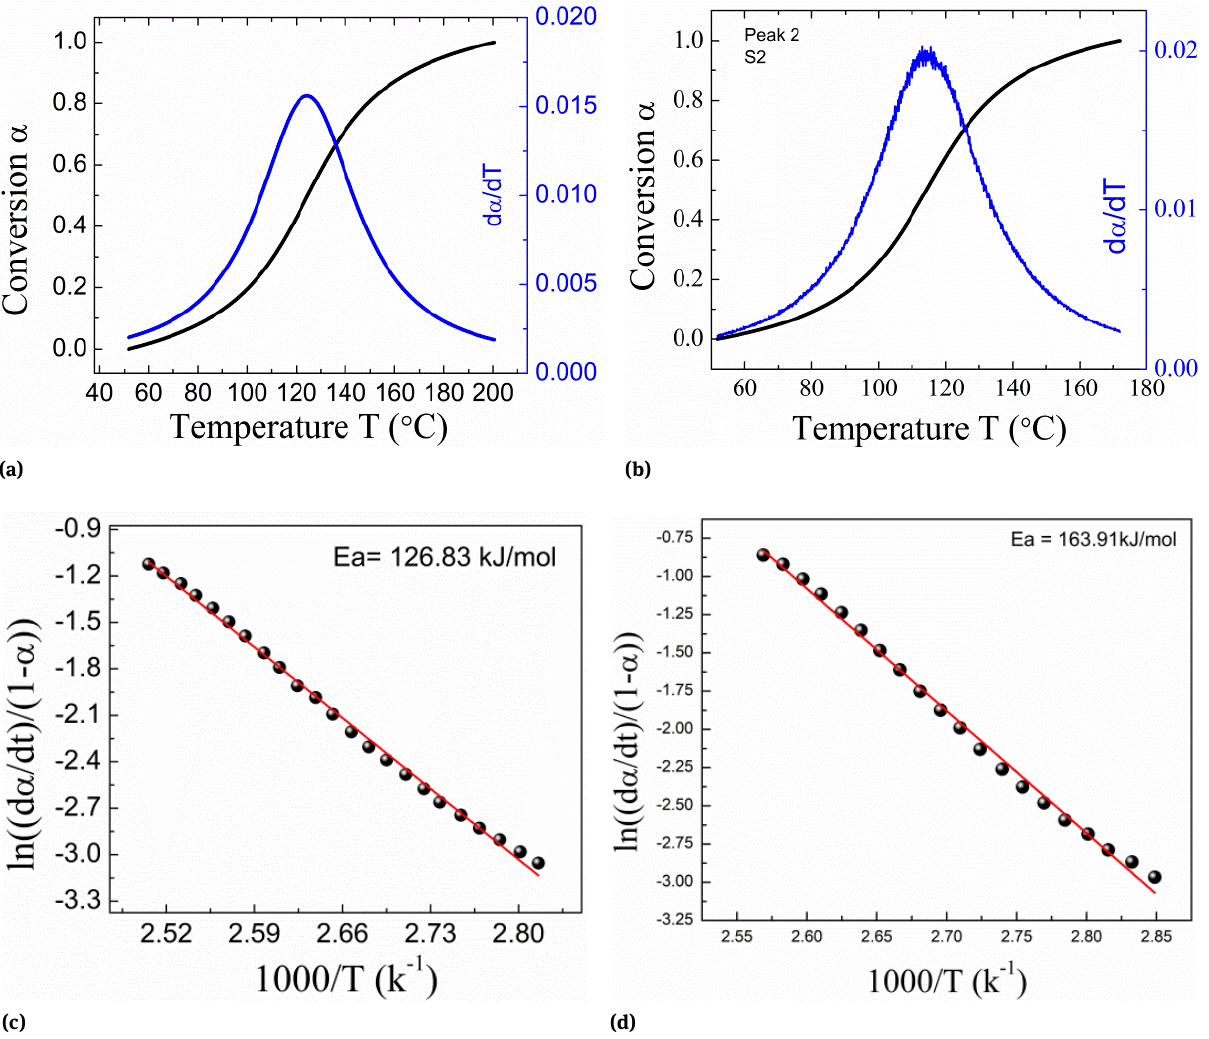
Figure 15: Conversion rate and its 1 st derivative for the a) first reaction and b) second reaction, and ln[(d α /dt)/(1 - α )] vs.1/T relation for the c) first reaction, and d) second reaction for the PVA/PANi/10 wt.% Fe 3 O 4